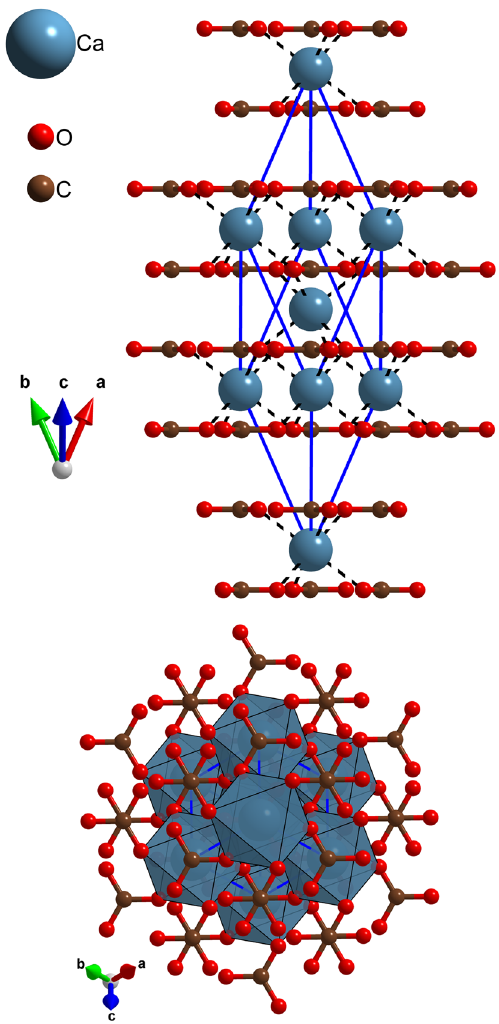
Figure 1. Rhombohedral cell of calcite, viewed along two crystallographic directions, [100] and [001] in the upper and lower panels, respectively. In the upper panel, the stacking of CO whereas in the lower panel, the polyhedrons indicate the octahedral coordination of the Ca 2+ ions in between the oxygen belonging to the carbonate